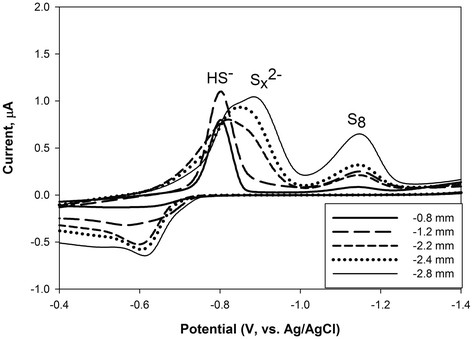
Representative voltammetric scans from pore waters through a core collected from Twinkie, showing sulfide-dominated conditions and conditions with higher elemental sulfur corresponding to higher levels of polysulfide. Sulfide sourced from thermal fluids oxidizes to elemental sulfur, additional sulfide then reacts with this elemental sulfur to form polysulfide, a key part of sulfur intermediate chemistry influencing overall sulfur cycling in this system.